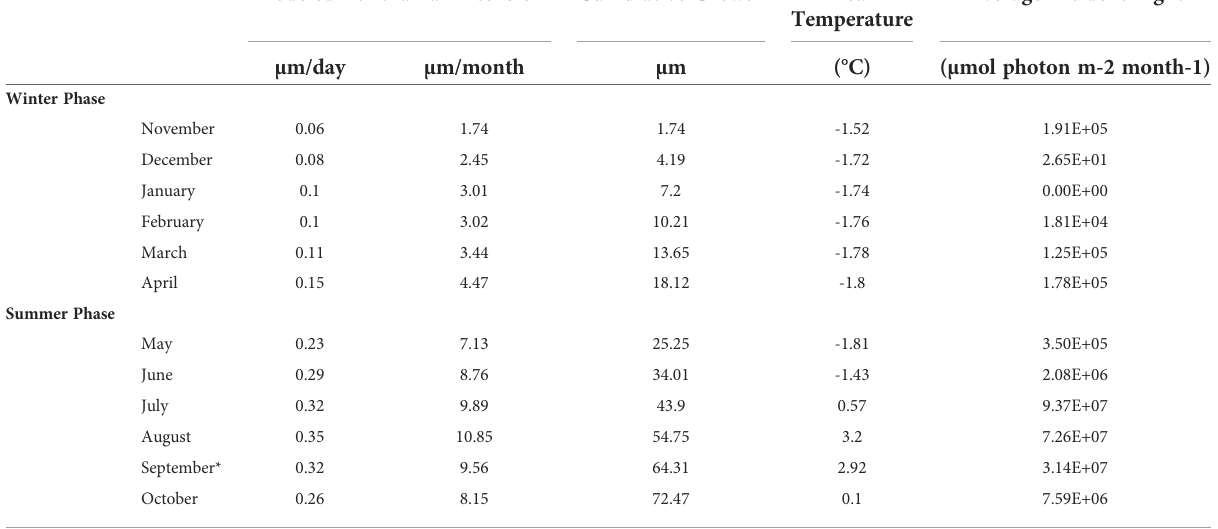
*Estimate using LOESS growth